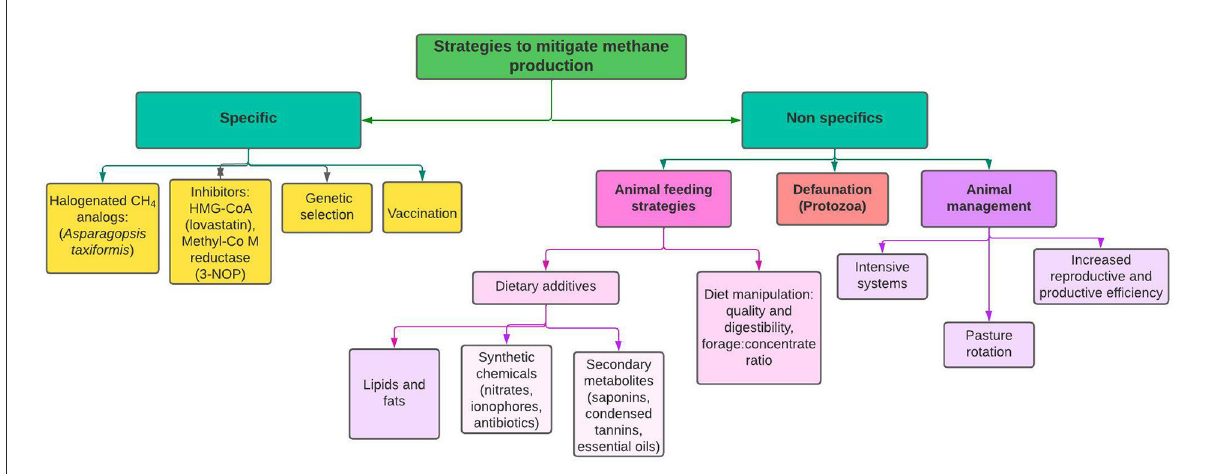
FIGURE1 Potential strategies for reducing enteric methane production in